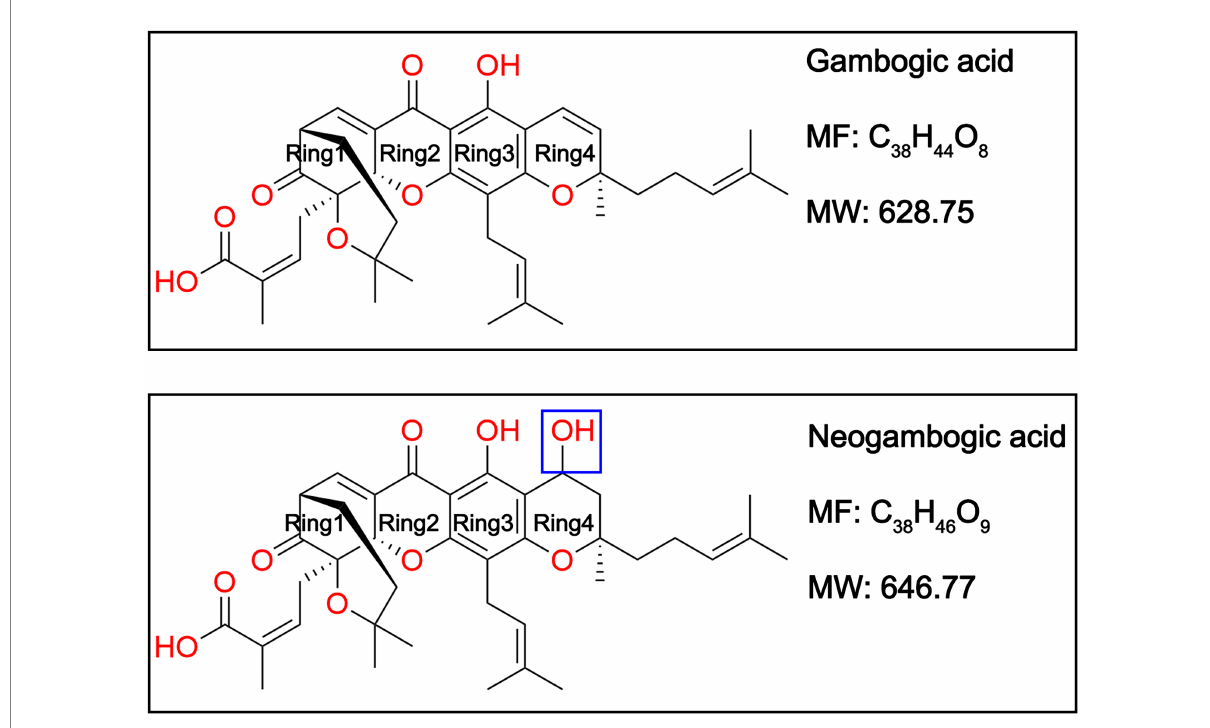
FIGURE 1 Chemical structures of gambogic acid (GA) and neogambogic acid